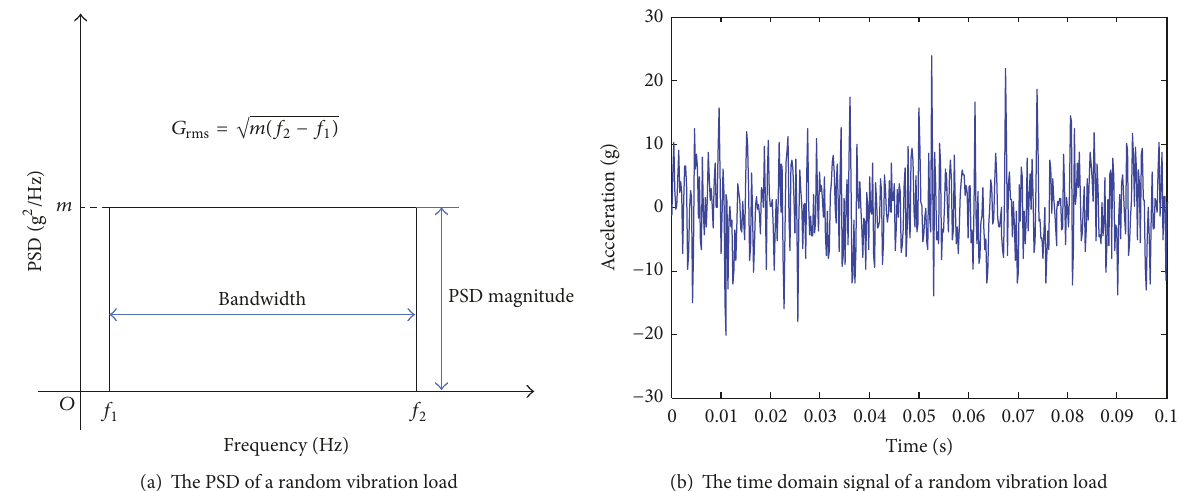
Figure 7: The random vibration load of fatigue test for composite